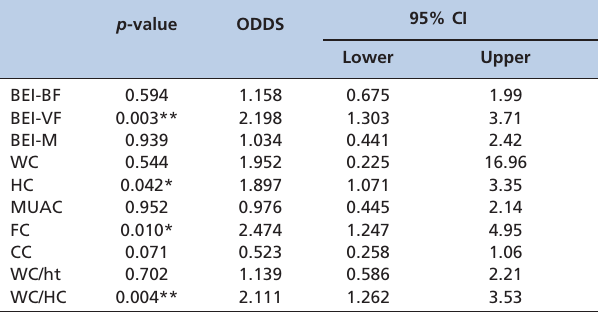
Table 3 - Results of logistic regression analysis using anthropometric measurements and body